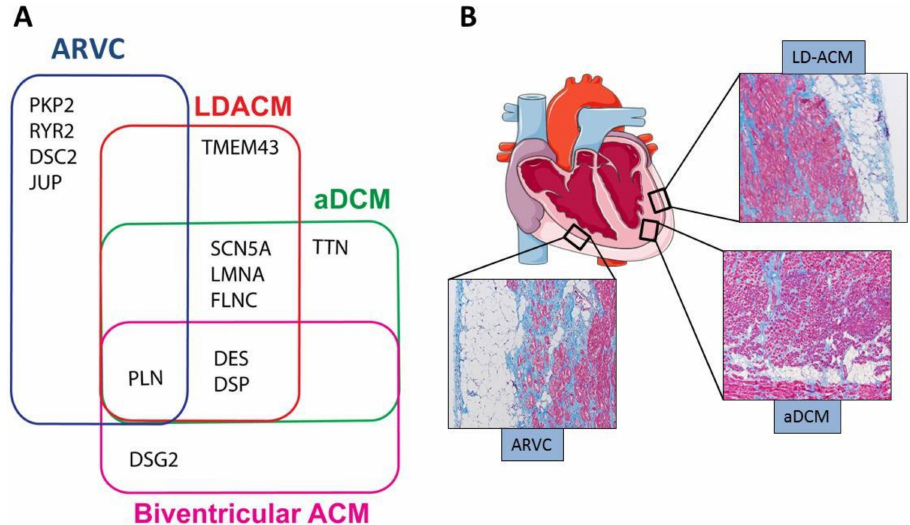
Figure 1. Genetic and histological hallmarks of ACM (arrhythmogenic cardiomyopathy). Panel ( A ) shows the genetic overlaps among the main ACM clinical phenotypes and a-DCM (arrhythmogenic dilated cardiomyopathy). Panel ( B ) shows the typical histological characteristics of ACM: fibroadiposis involving the epicardial layer of the RV (right ventricle) in ARVC (arrhythmogenic right ventricular cardiomyopathy), theepicardialareaoftheLV(leftventricle)inLD-ACM(left-dominantarrhythmogenic cardiomyopathy) and the midwall of the LV in